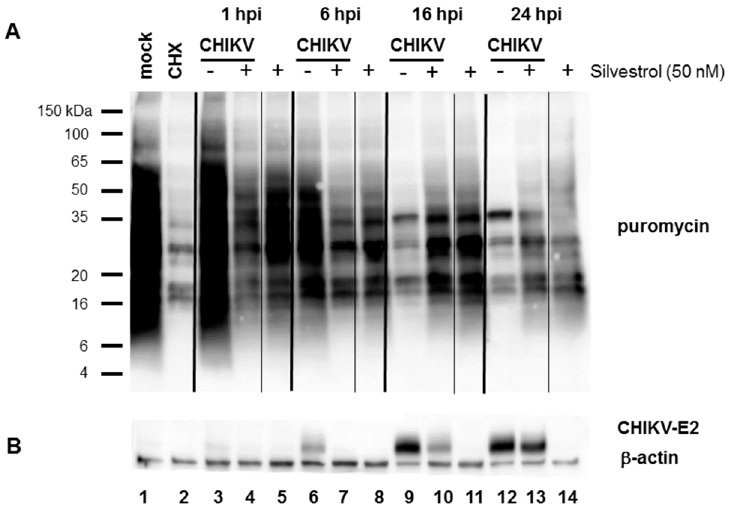
Figure 4. Analysis of cellular protein synthesis during CHIKV infections in the presence of 50 nM silvestrol. HEK 293T cells were infected with CHIKV at an MOI of 10 and either treated with 50 nM silvestrol (+) or left untreated ( − ). Cells were harvested after the indicated times of infection. Before harvest, cells were treated with 5 mg/mL puromycin for 30 min. ( A ) Detection of proteins with a puromycin-specific antibody. CHX: cycloheximide; ( B ) Detection of the CHIKV-E2 protein and β -actin as the loading control.